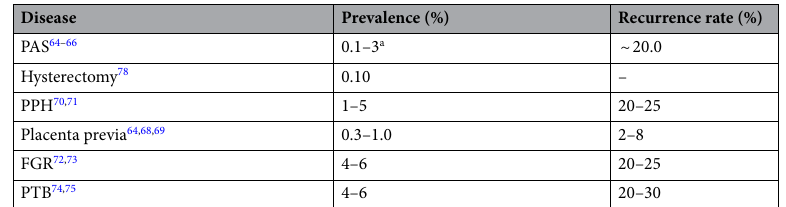
Table 4. The estimated prevalence of obstetric complications and the recurrence rate of each complication. PAS placenta accreta spectrum, PPH postpartum hemorrhage, FGR fetal growth restriction, PTB preterm birth. a Including pathological and clinical diagnosis of placenta accreta